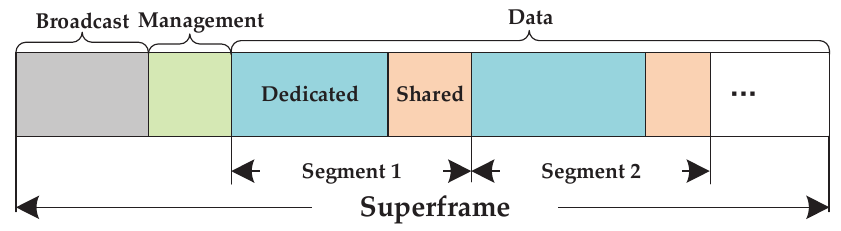
Figure 2. The structure of a